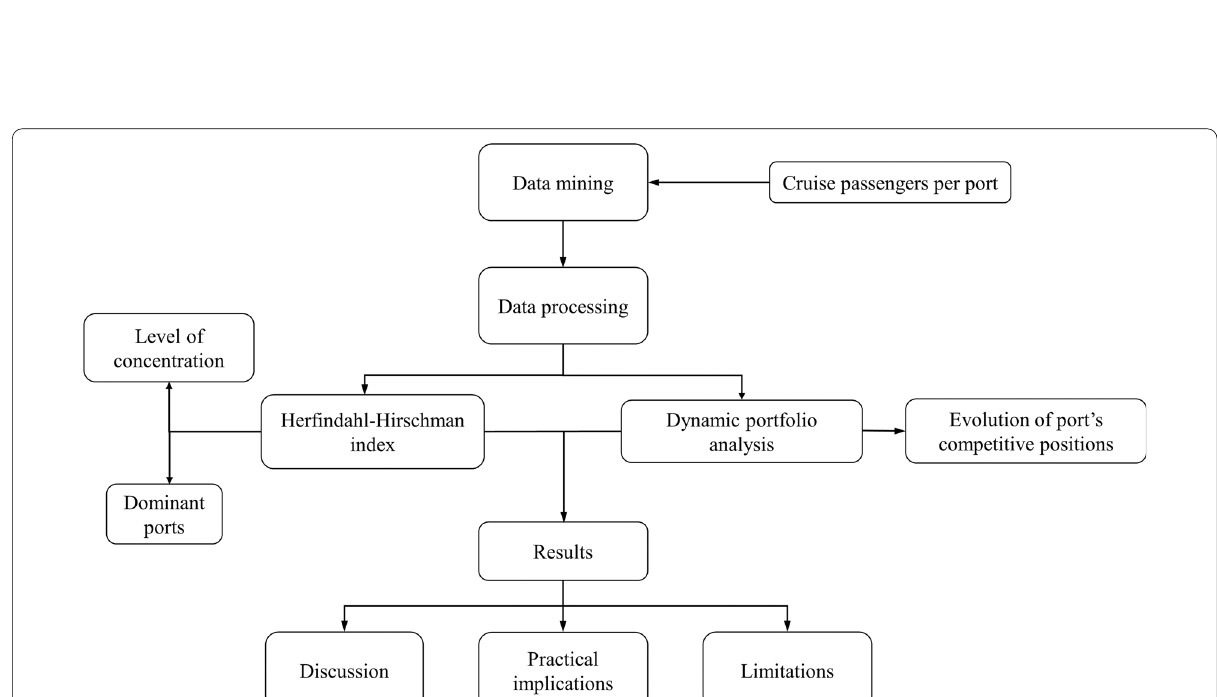
Fig. 3 Research design flow chart. Source : Author’s